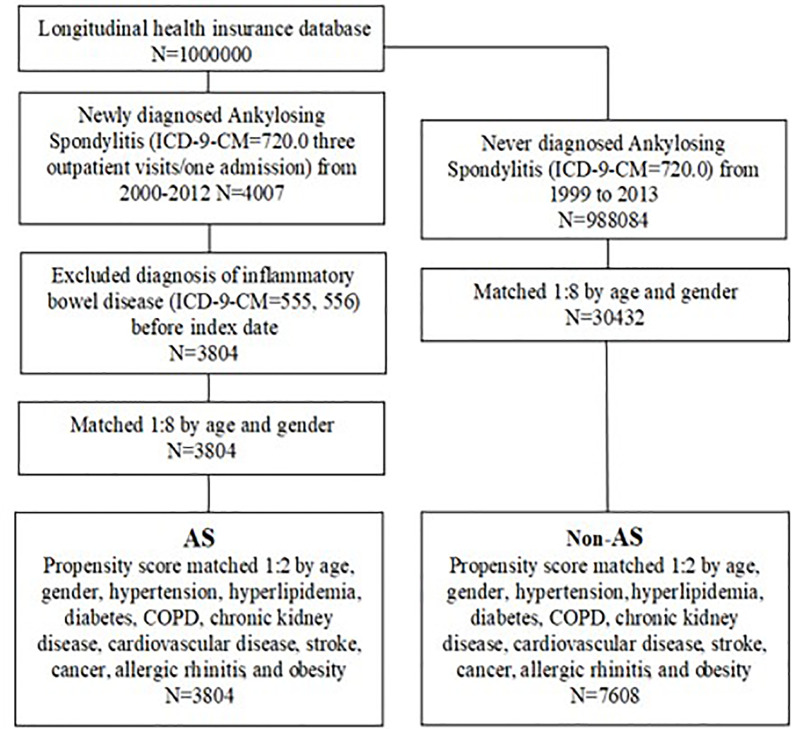
Flowchart of the sample selection.